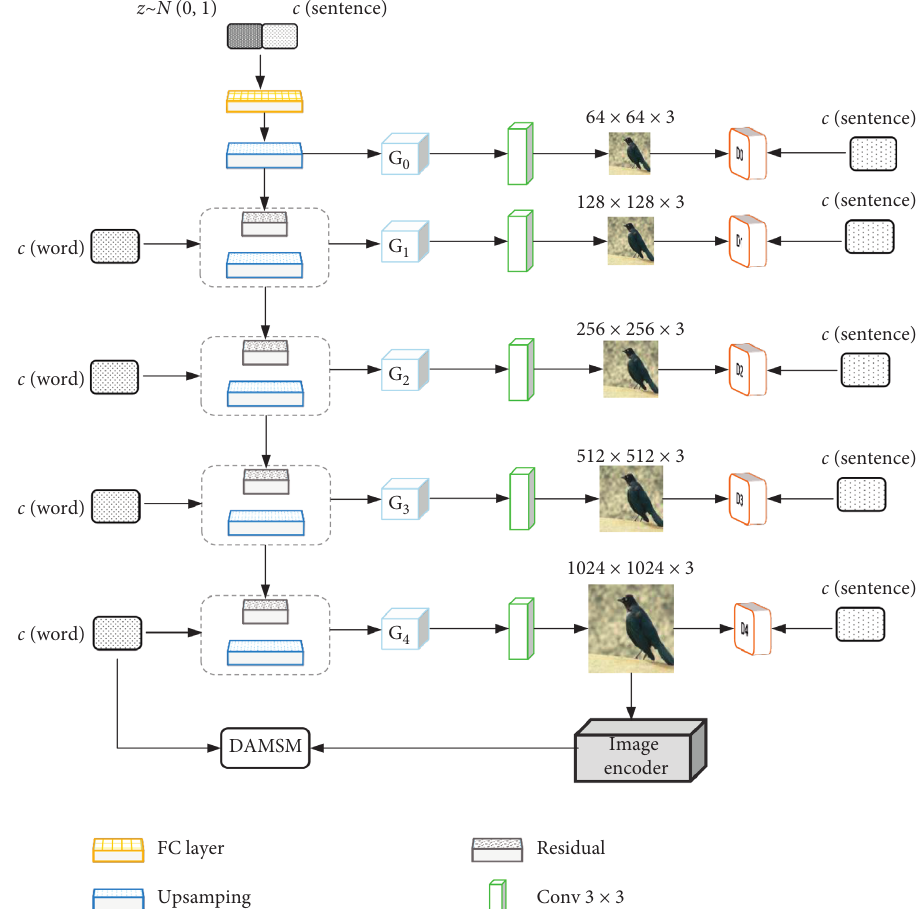
Figure 1: Attentional Concatenation Generative Adversarial Networks Model. Our training starts with both the generator and dis- criminator having a low spatial resolution of 64 × 64 pixels. As the training advances, we incrementally add layers to G and ( D ), thus increasing the spatial resolution of the generated